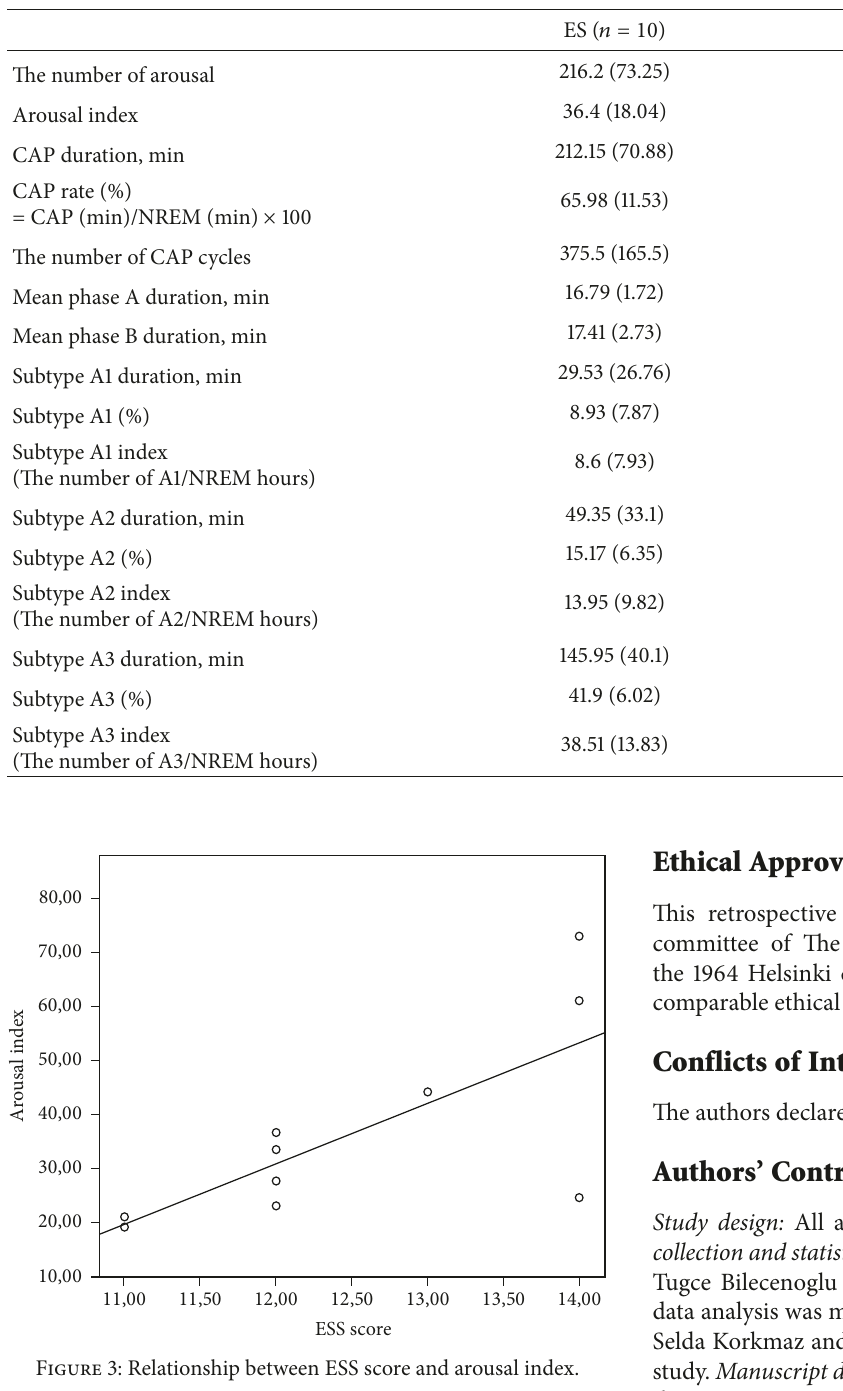
Table 4: Spearman’s Correlation Coefficients between ESS score and the parameters of sleep architecture in ES group.